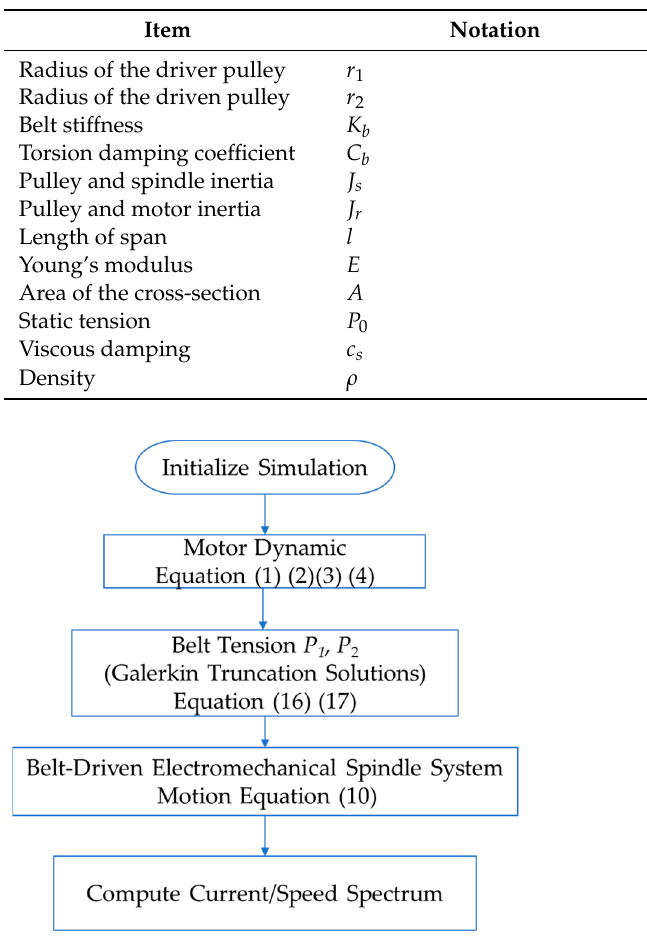
Table 2. Properties of the belt-driven electromechanical spindle system.